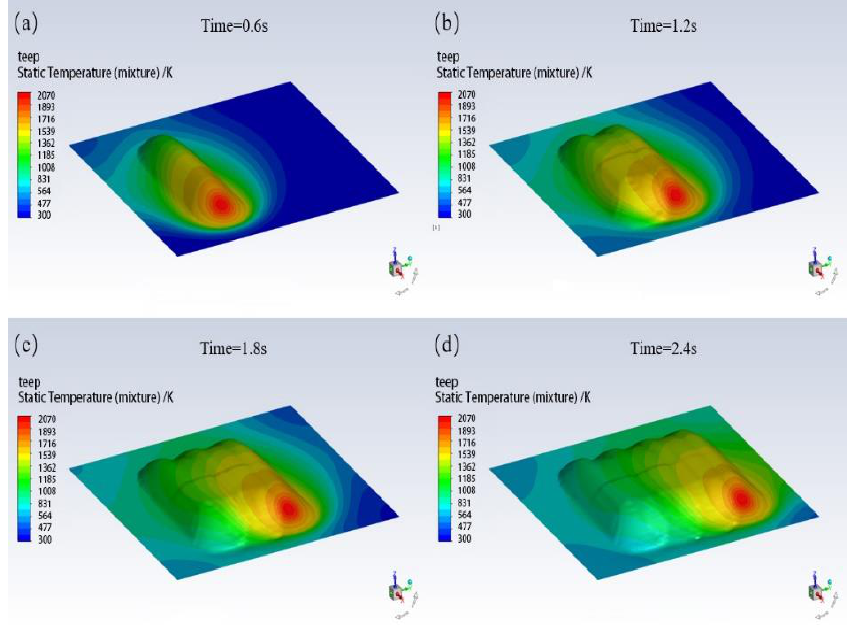
Figure 18. Variation of temperature field with time for single-layer multi-laser processing. ( a ) 0.6 s; ( b ) 1.2 s; ( c )1.8 s; ( d ) 2.4 s.